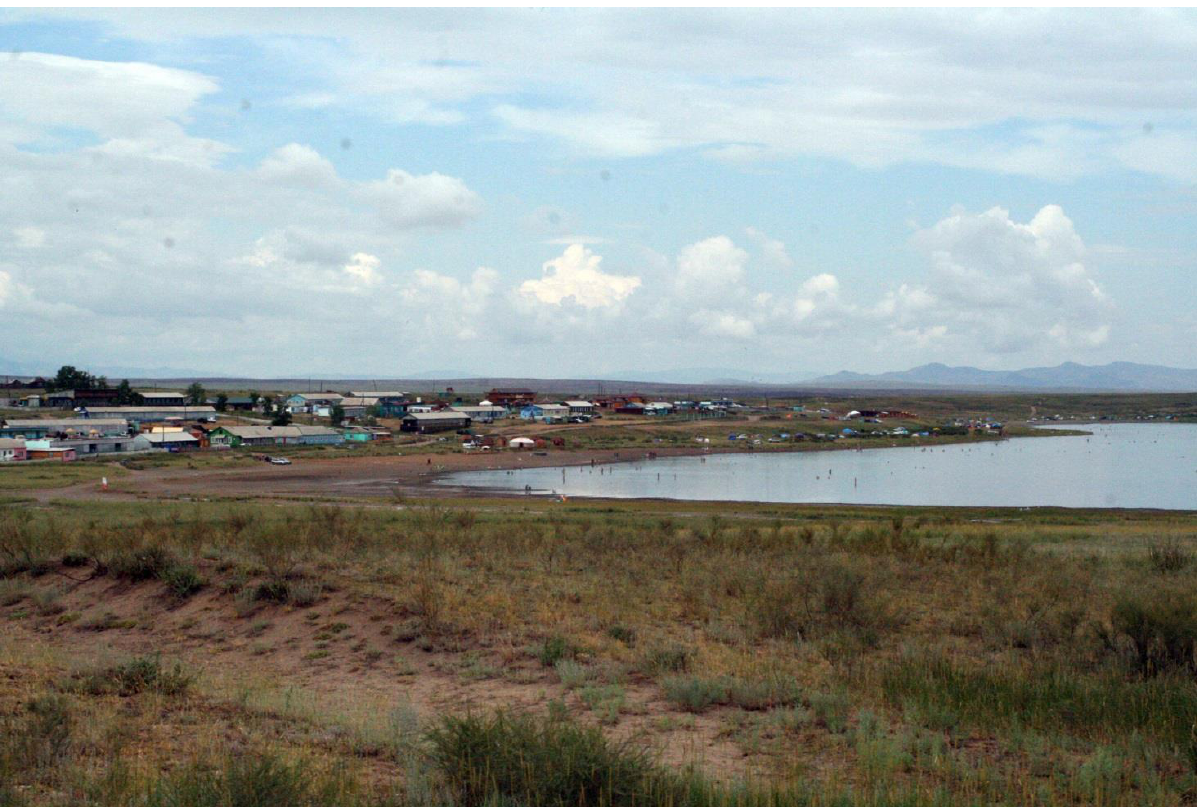
Fig. 3. Salt Lake Dus-Khol. Tanda Kozhuun, 2 July 2017.